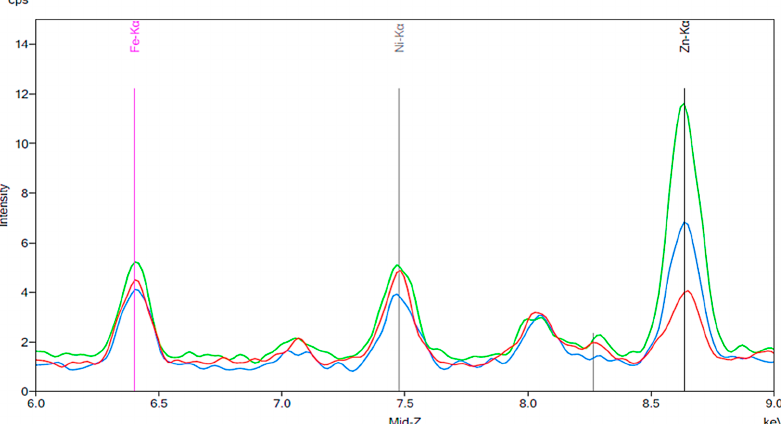
Figure 14. Baseline spectrum for a sample of red wine. The parameters used are the same as those described for the other baseline spectra previously discussed in this paper.